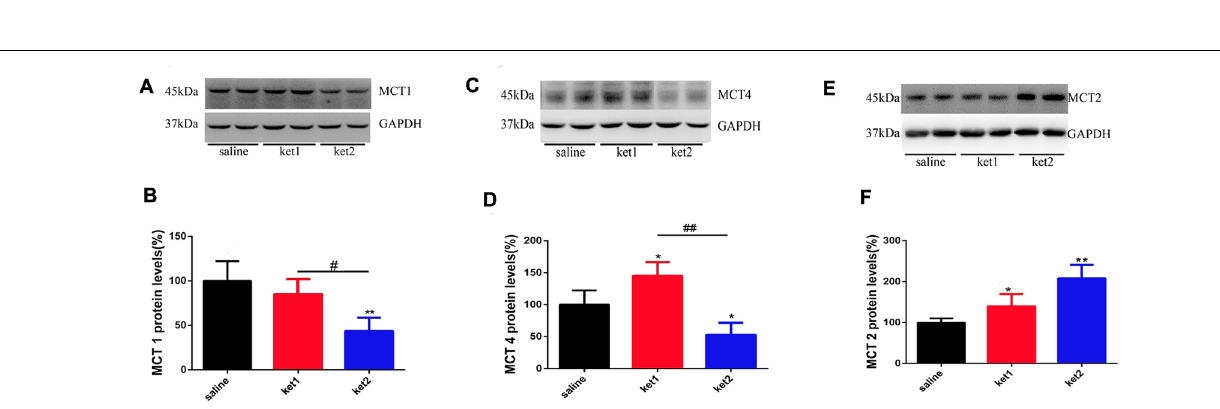
FIGURE 4 | Changes of hippocampal membrane monocarboxylate transporters 1 (MCT1), MCT4 and MCT2 protein levels after 6 months of ketamine administration in different groups as revealed by Western blot. (A,B) Significant decline of MCT1 expression levels were seen in ket2 group comparing with ket1 group and control group respectively ( F (2,27) = 3.405, # p < 0.05 and F (2,27) = 5.823, ** p < 0.01, respectively). (C,D) Significant decline of MCT4 expression levels were seen in ket2 group comparing with control group and ket1 group respectively ( F (2,27) = 3.442, * p < 0.05 and F (2,27) = 5.604, ## p < 0.01, respectively). Obviously increase of MCT4 expression levels were seen in ket1 group comparing with control group ( F (2,27) = 3.482, * p < 0.05). (E,F) Significant increase of MCT2 expression levels were seen in ket2 and ket1 group comparing with control group respectively ( F (2,27) = 6.104, ** p < 0.01; F (2,27) = 3.707, * p < 0.05, respectively; saline n = 10, ket1 n = 10, ket2 n =